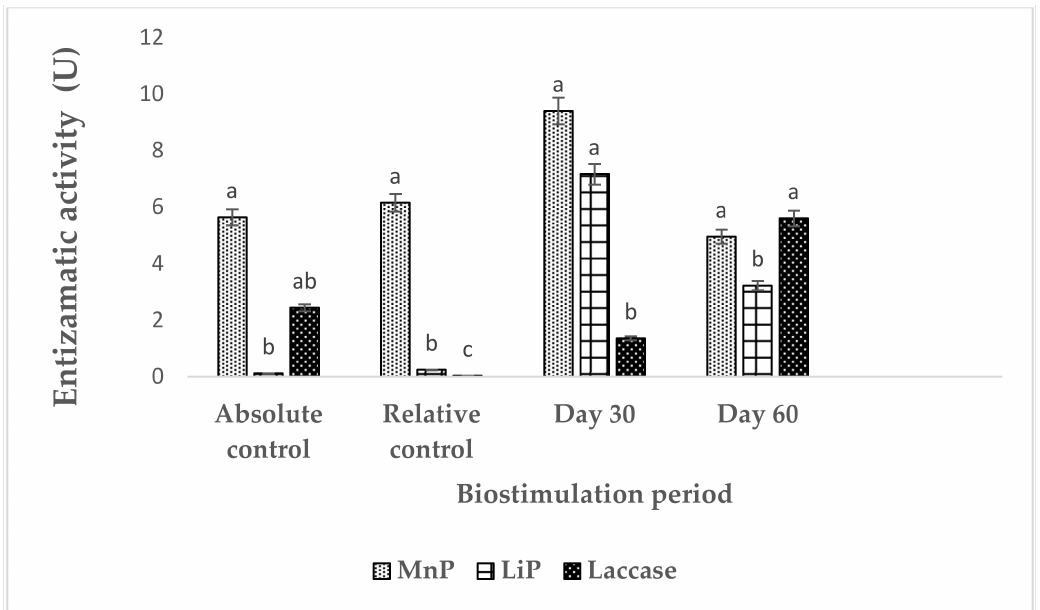
Figure 2. Enzymatic activity in soil impacted by 34,500 ppm of waste motor oil biostimulated applied crude fungal extract and Cicer arietinum as a green manure. Notes: LiP = Lignin peroxidase; MnP = Manganese peroxidase, CFE = crude fungal extract, GM = green manure, MISO = mineral solution, WMO = waste motor oil. Different letters indicate statistical difference according to ANOVA- Tukey ( p < 0.05). Number repetitions ( n ) =